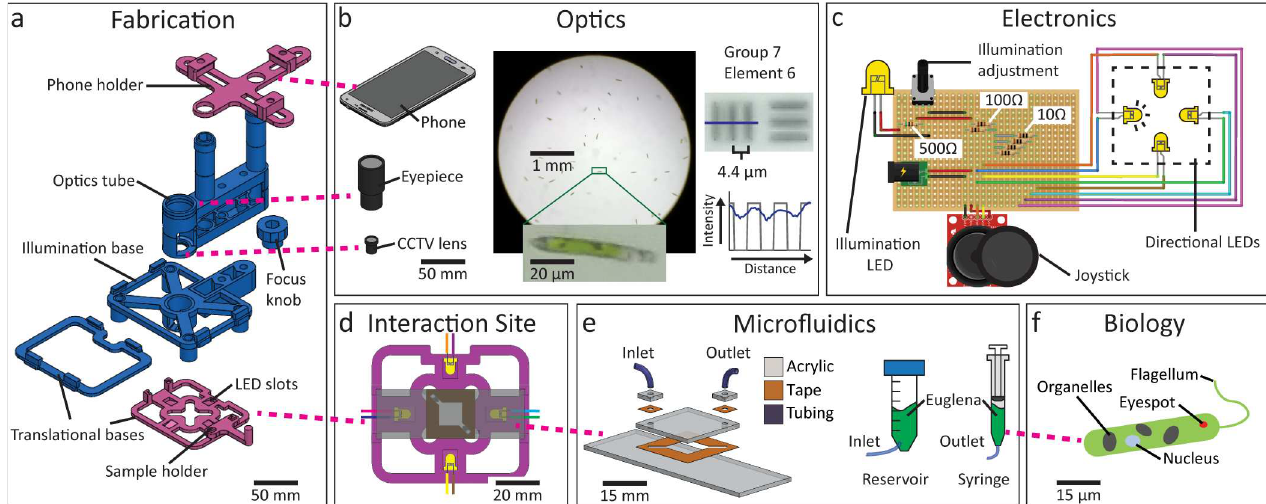
Fig 2. BUILD:All components of the LudusScope are designedto allow straightforward do-it-yourself (DIY)reproduction and emphasize learning in construction, optics, electronics,microfluidics, and microbiology. ( A ) Computer-aided design and assembly of the 3D-printed components of the LudusScope. Alternatively, a variationof the sampleholderand phone holder(pink)enable mountingto a conventional microscope (S1 Fig).( B ) The opticalcomponents consist of a smartphone camera,an eyepiece, and a closed-circuit television (CCTV)boardlens. Utilizinga conventional eyepiece allows two-way compatibility of the smartphoneand softwarewith regularmicroscopes. The DIY scope is able to resolve Group7, Element6 targets,corresponding to a resolutionof 4.4 μ m. ( C ) Simpleelectroniccircuitfor analoglight stimulus controlof the four LEDs via joystick; a potentiometer controls the illumination LED of the microscope. ( D ) Sample holderwith microfluidic slide and four directional LEDs pointingtoward the centerof the holder. ( E ) The microfluidic chamber is built via sticker microfluidics. A pair of syringereservoirsconnected to both ends of the chamberallows long-term Euglena culturing.( F ) Euglena is used given its robust phototacticbehavior and easy culturing